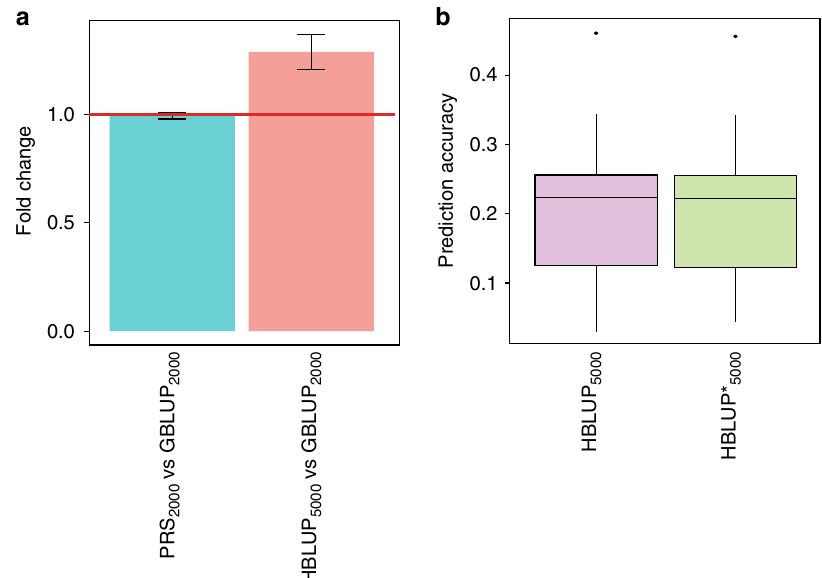
Fig. 7 Prediction performances with and without phenotypic information of ungenotyped relatives of the target sample. a The fold change of prediction accuracy using PRS from GWAS summary statistics with respect to that using GBLUP (PRS 2000 vs GBLUP 2000 ) and the fold change of HBLUP accuracy with respect to GBLUP accuracy (HBLUP 5000 vs GBLUP 2000 ). The main bars represent the mean values of the fold changes averaged over the analyses of 50 complex traits. The error bars show the 95% con fi dence intervals of the mean fold changes. The red horizontal line indicates a ratio of 1. The subscript in the name of each method represents the sample size in the discovery data set. b HBLUP prediction accuracy with (HBLUP 5000 ) and without (HBLUP* 5000 ) using pedigree information between ungenotyped relatives of the target samples and other individuals in the discovery sample. The boxplots show the fi rst to the third quartile of prediction accuracies for 50 complex traits, and the whiskers re fl ect the maximum and minimum values within 1.5 × interquantile range for each group. PRS 2000 : Polygenic Risk Score with 2000 genotyped individuals only, GBLUP 2000 : best linear unbiased prediction integrated with genomic relationship matrix with 2000 genotyped individuals only. HBLUP 5000 : best linear unbiased prediction with H-matrix including 2000 genotyped and 3000 ungenotyped relatives of the target samples in the discovery